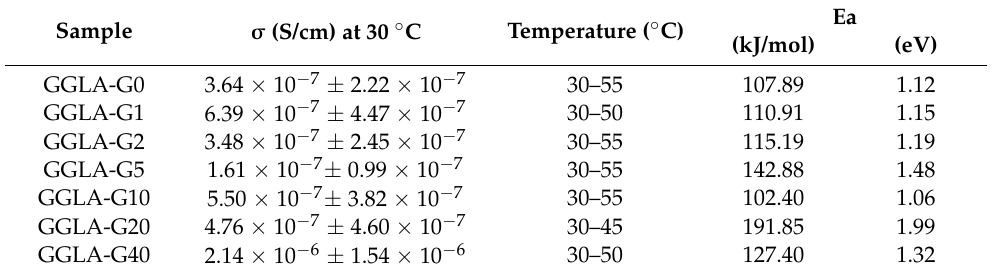
Table 1. Ionic conductivity and activation energy at low temperatures of GGLA SPEs.